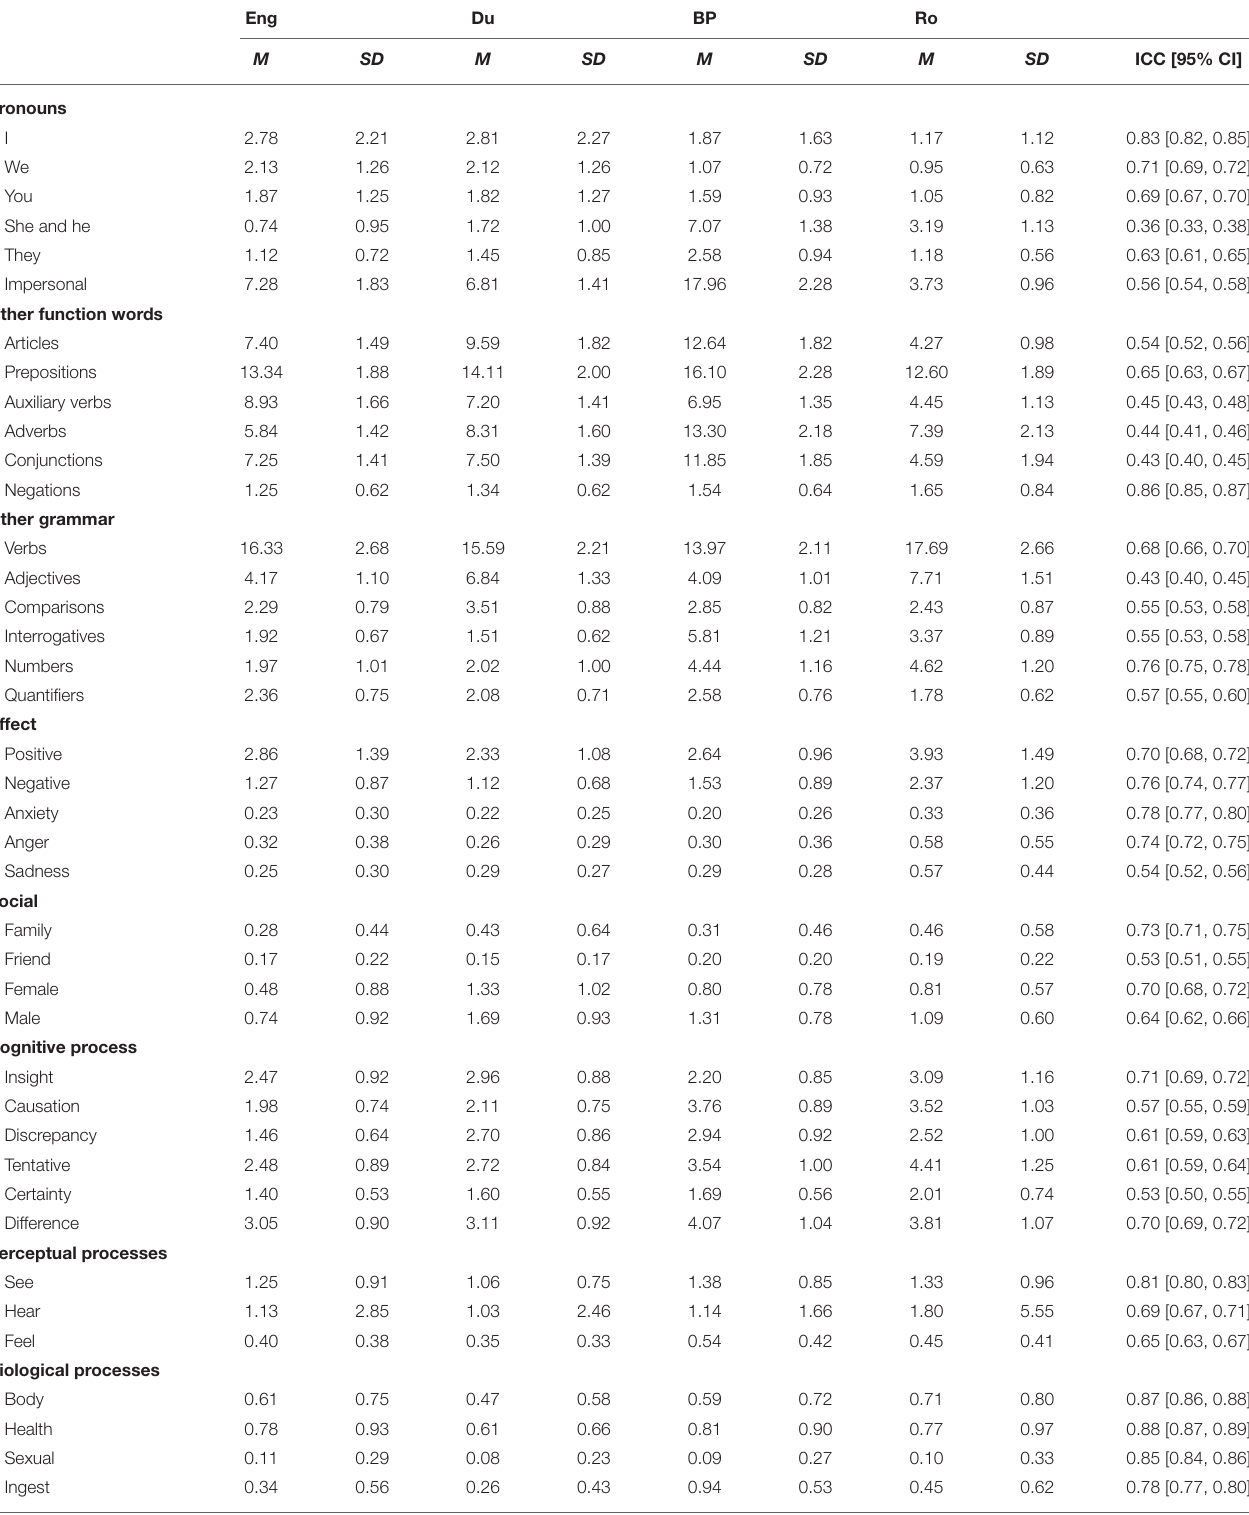
TABLE 2 | Means ( M ) and standard deviations ( SD ) for the word percentages obtained with each LIWC2015 dictionary and the intraclass correlation coefficients (ICC) for the between-dictionary